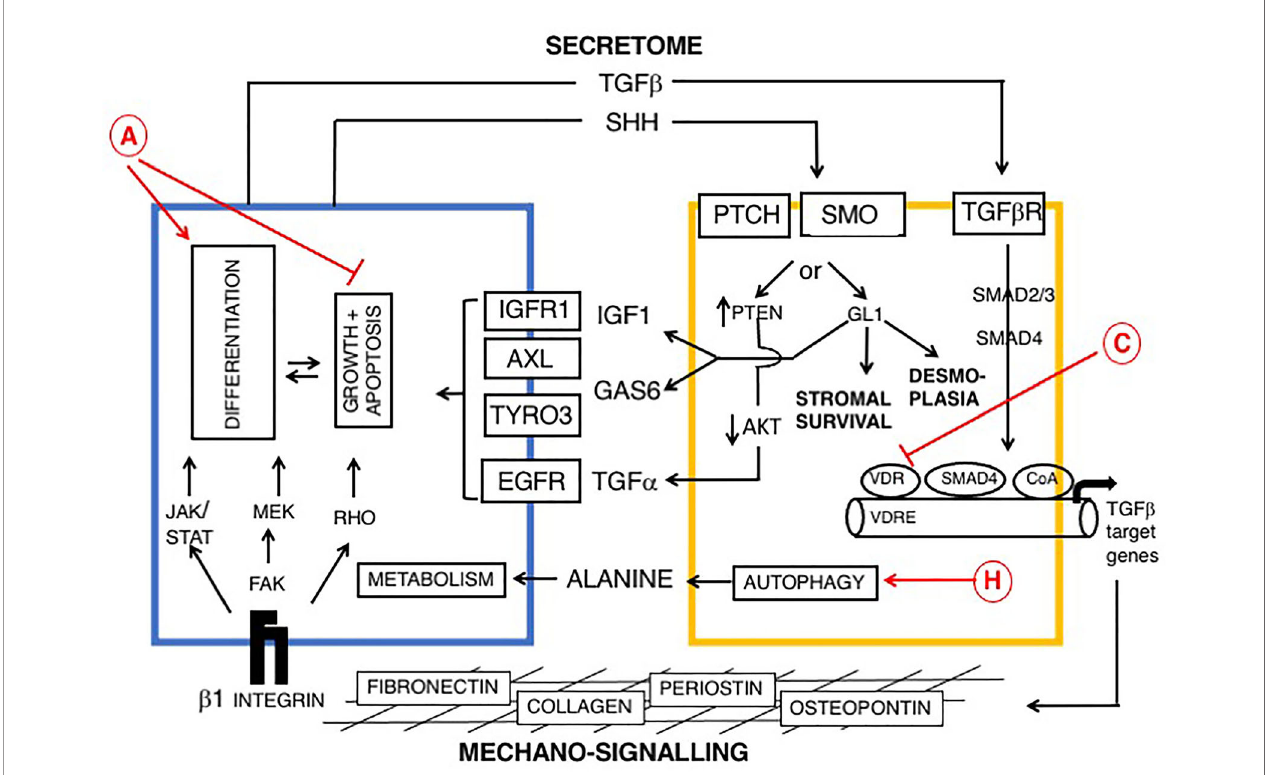
FIGURE 2 | Reciprocal signaling pathways between PDAC and myo fi broblasts (myCAFs) and role of vitamin D, modi fi ed from (169, 176, 177). Cells are colored as in Figure 1 . Epithelial (PDAC) cells are blue and stromal cells, (PSCs) are yellow. Two broad pathways are shown: a PDAC-derived secretome, including TGF- b and Sonic hedgehog (SHH), upper and mechano-signaling via ECM/ b -1 integrin and FAK (lower part of fi gure). TGF- b drives a myo fi broblast phenotype. SHH signals via GLI to promote dysplasia. Ligands derived from myCAFs (including IGF1, AXL, TYRO3 and TGF a ) support tumor growth and inhibit apoptosis. Predicted effects of vitamin D are labeled A-J as described in Table 6 , where labels indicate: A Pro-Differentiation and Anti-Proliferation; C Inhibition of fi brosis and down-regulation of TGF- b -SMAD-dependent transcription of pro- fi brotic genes and H Promotion of autophagy in PDAC cells and CAFs with provision of alanine to PDAC cells (178,